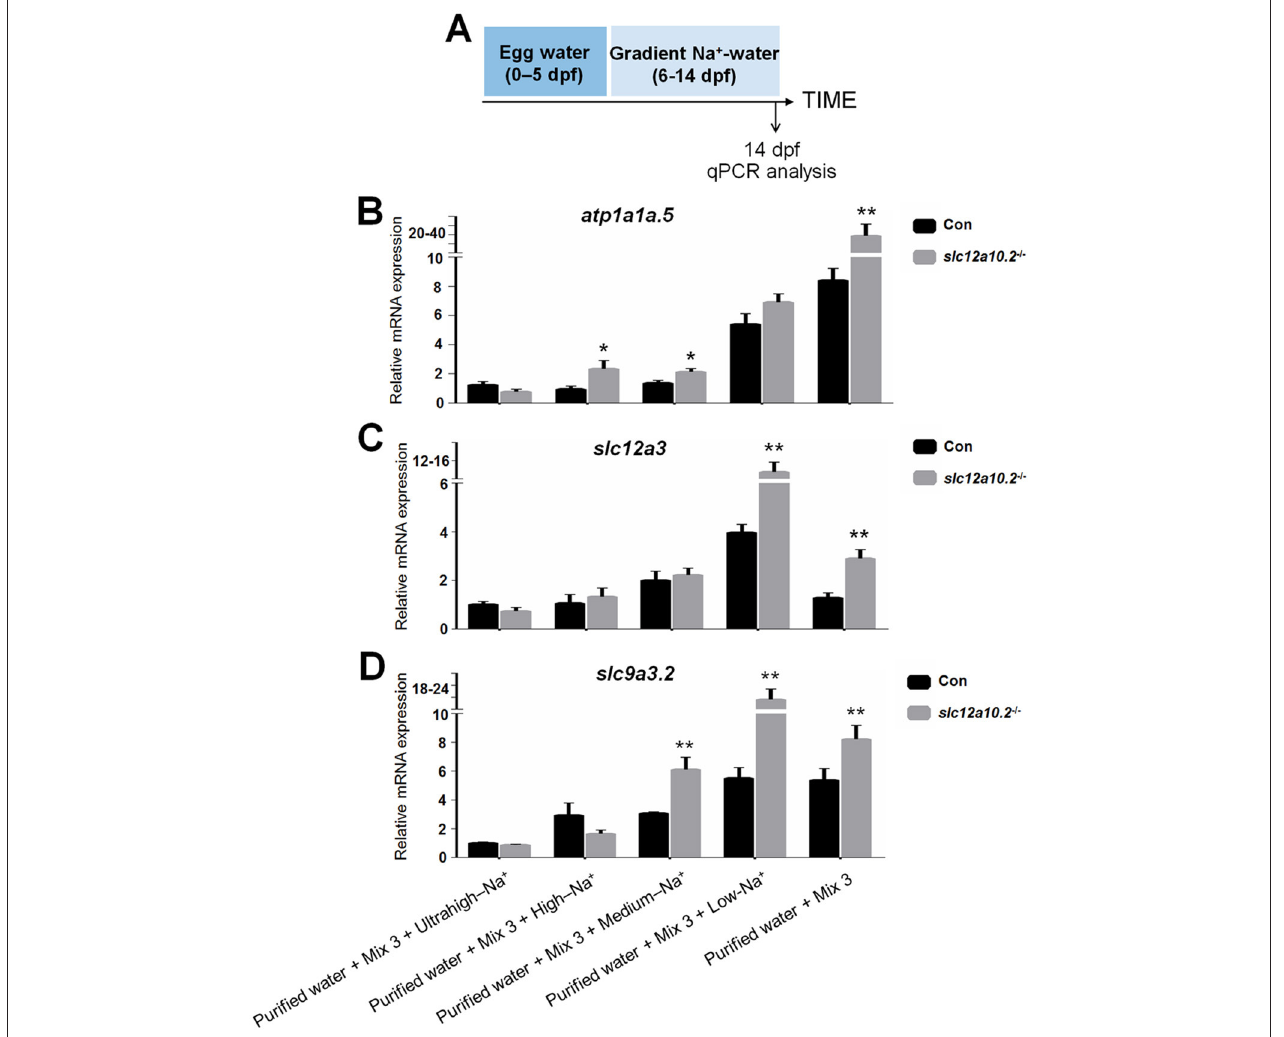
FIGURE 4 | Hypo-Na + , not standard conditions, upregulates the expressions of the transporters. (A) Schematic diagram of the rearing timeline. Larvae were harvested at 14 dpf for qPCR analysis. (B–D) Expression levels of atp1a1a.5 , slc12a3 , and slc9a3.2 were examined in the control and slc12a10.2 -deficient larvae reared in purified water + Mix 3 + ultrahigh-Na + , purified water + Mix 3 + high-Na + , purified water + Mix 3 + medium-Na + , purified water + Mix 3 + low-Na + , and purified water + Mix 3, from 6 to 14 dpf. * P < 0.05. ** P <